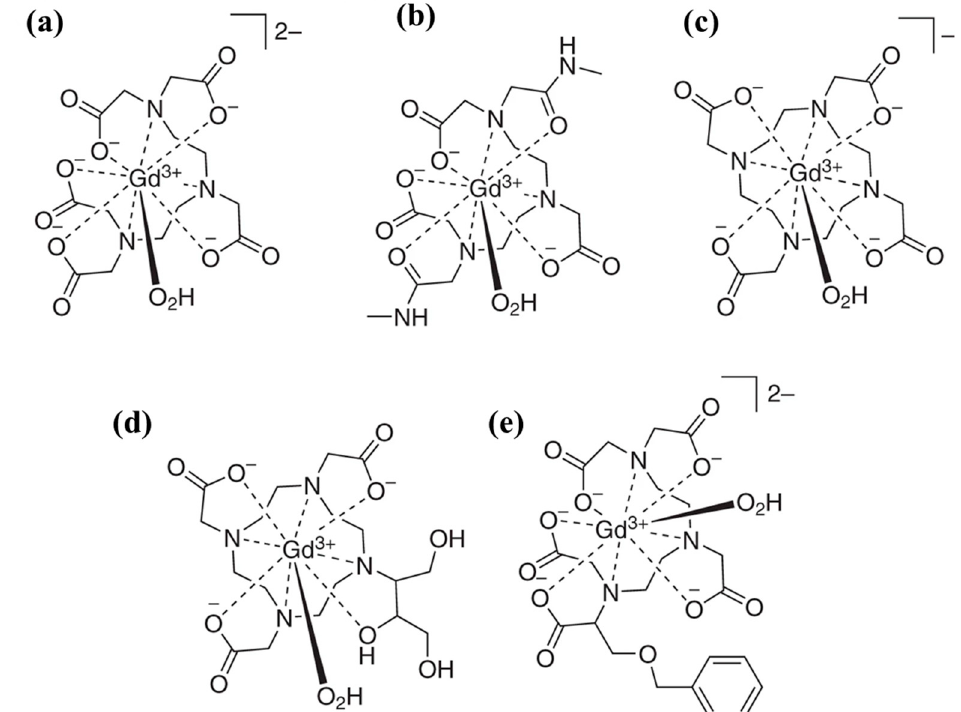
Figure 1. Chemical structures of five most commonly administered gadolinium-based contrast agents for clinical MRI: ( a ) Magnevist ® , [Gd(OH 2 )(dtpa)] 2 − ; ( b ) Omniscan ® , [Gd(OH 2 )(dtpa-bma)]; ( c ) Dotarem ® , [Gd(OH 2 )(dota)] − ; ( d ) Gadovist ® , [Gd(OH 2 )(do3a-butrol)]; and ( e ) Multihance ® , [Gd(OH 2 )(bopta)] 2 − . Reproduced with permission from Reference [46]. Copyright 2019 Springer Nature.